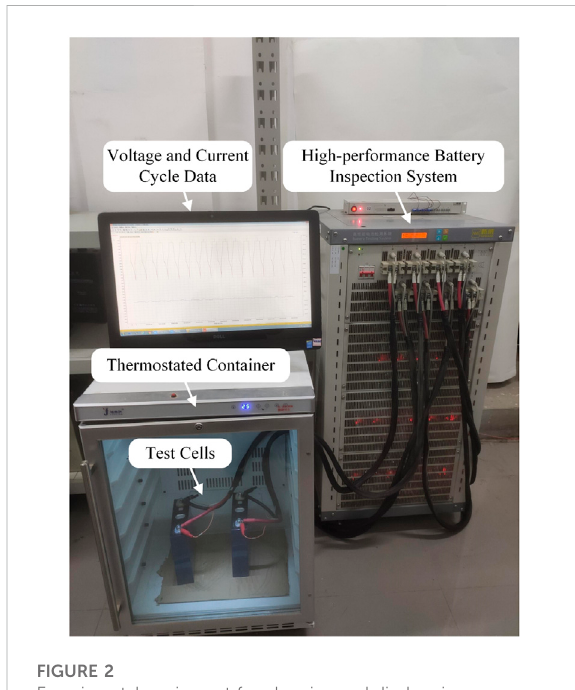
FIGURE 2 Experimental equipment for charging and discharging.